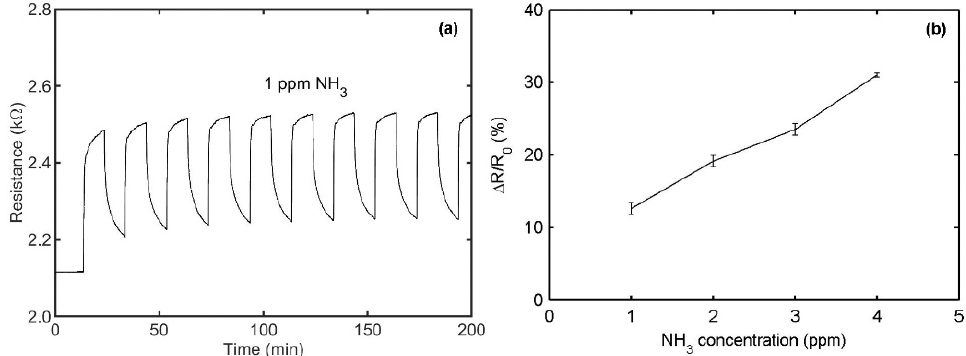
Figure 11. Sensing behaviors of a typical PPy/reduced graphene oxide (rGO) sensor at relative humidity of 50% and at 20 °C: ( a ) The sensor resistance behavior to 1 ppm NH 3 for 10 cycles. ( b ) The sensor resistance response as a function of NH 3 concentration. Reproduced from (Xiaohui Tang, [135]), Copyright 2020, Elsevier.